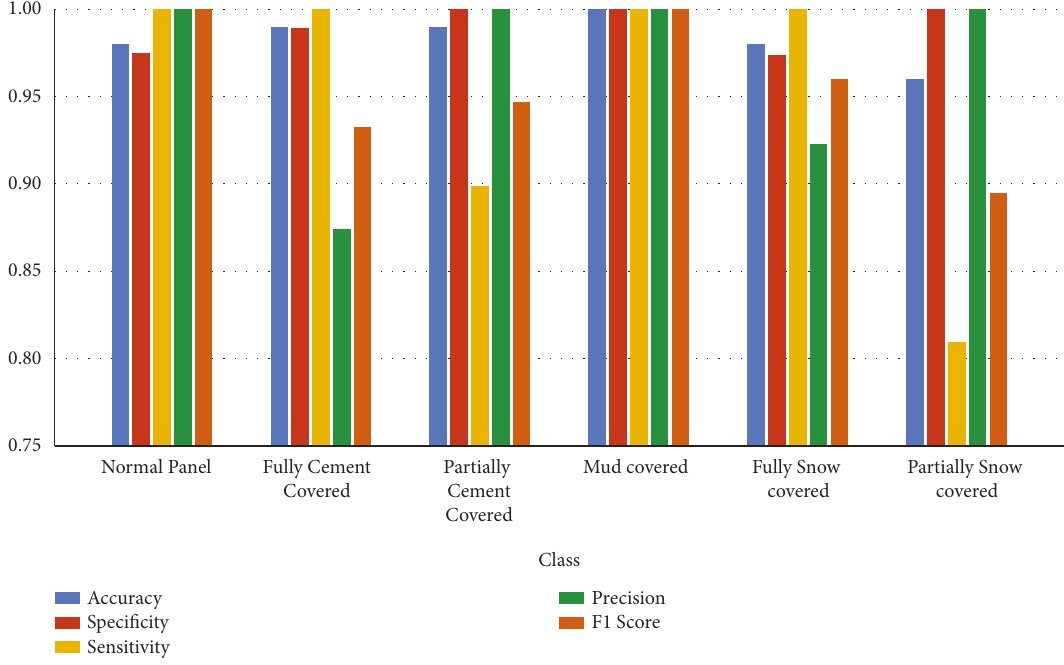
Figure 14: Statistical measures for AlexNet.